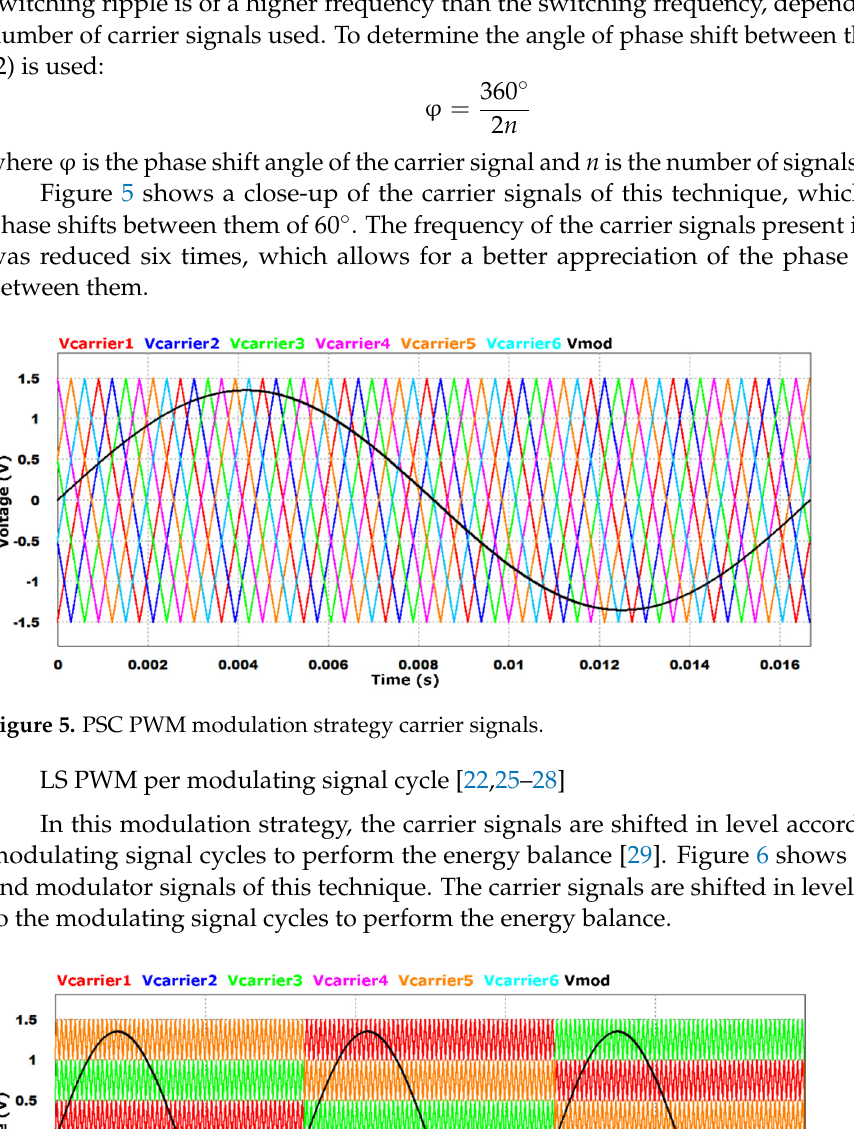
Figure 5. PSC PWM modulation strategy carrier signals.